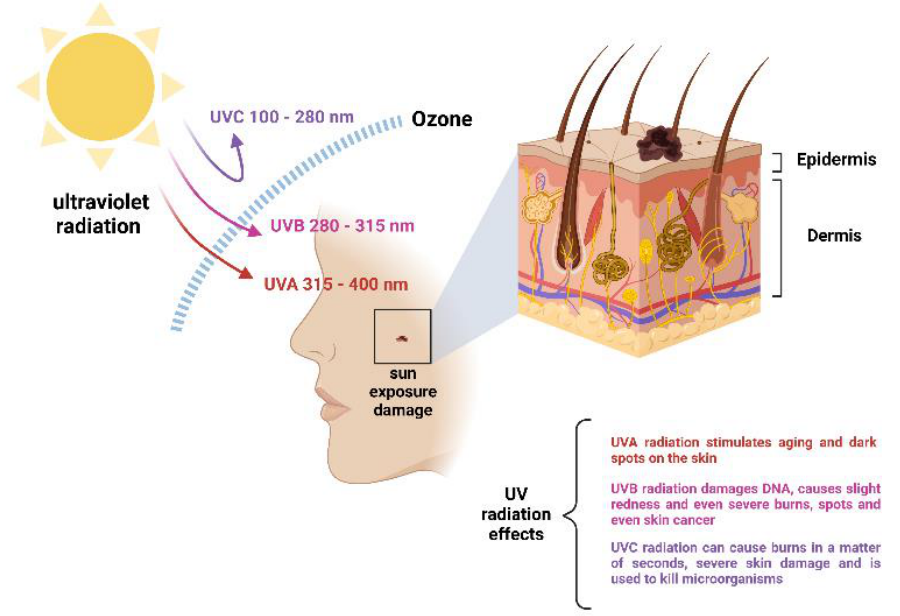
Figure 1. Scheme of types of UV radiation and its penetration into the skin. Figure was created with BioRender.com.